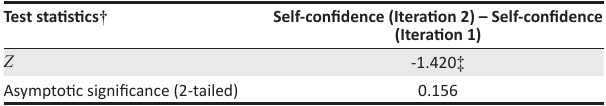
TABLE 5 : Test statistics for the self-confidence sub-scale.